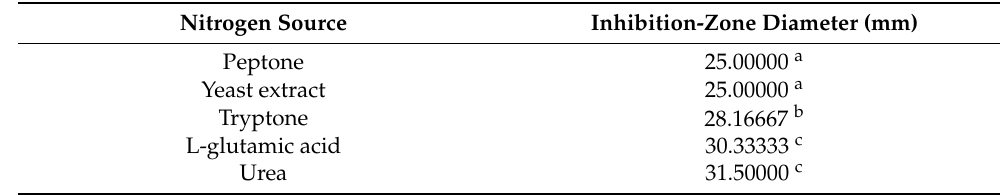
Table 5. Mean values of inhibition-zone diameters obtained by testing the cultivation broth samples against the aflatoxigenic isolates in the nitrogen source selection investigation step.